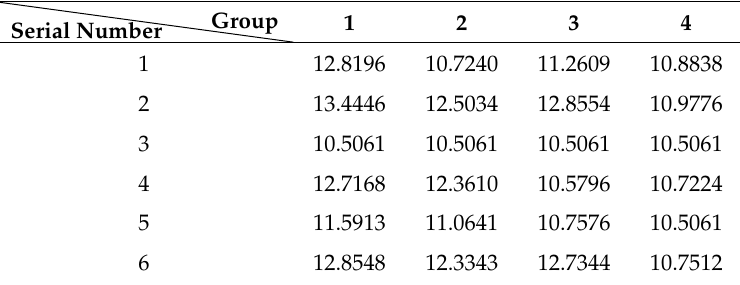
Table 3. Fitness function values for each generation of